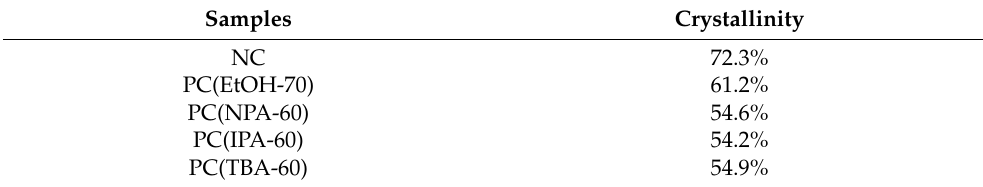
Table 1. Crystallinity of natural fiber and different pretreated fibers. Samples Crystallinity